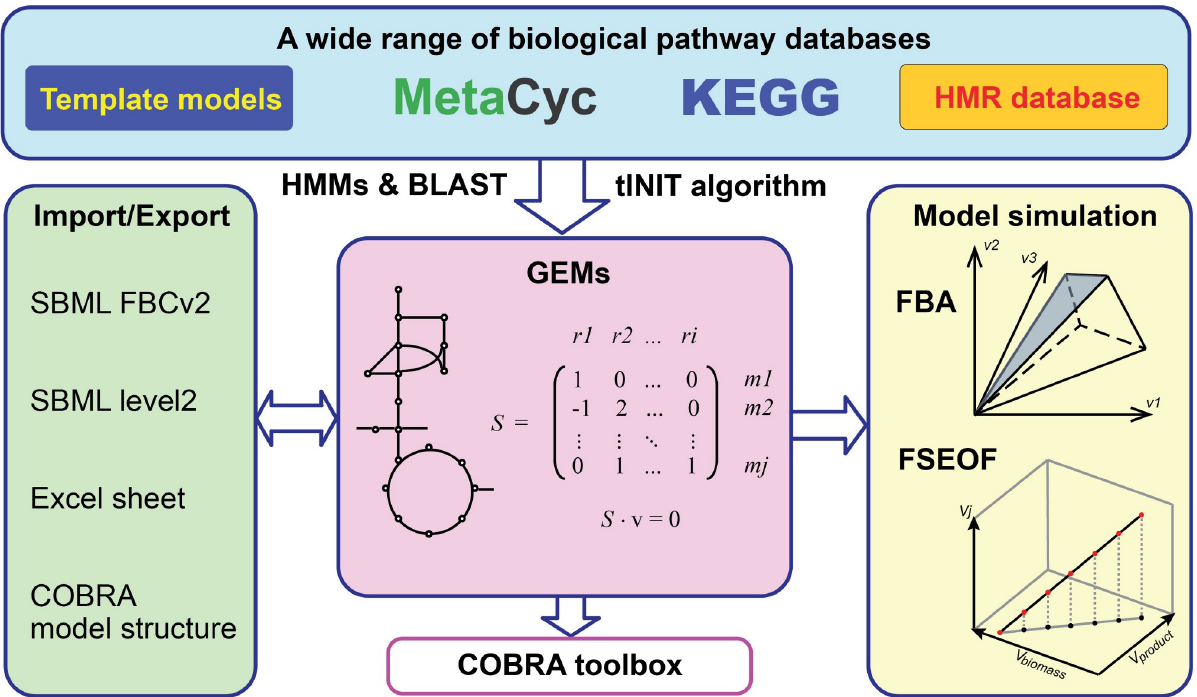
Fig 1. Schematic overview of RAVEN toolbox version 2.0. RAVEN was significantly enhanced for de novo draft model reconstruction by integrating knowledge from different sources (e.g. KEGG and MetaCyc). It has better import/export support to relevant formats, and especially improved compatibility with the COBRA Toolbox by resolving previously conflicting function names and providing a bi-directional model conversion function. As a MATLAB toolbox, RAVEN provides one unified environment for both model reconstruction and simulation analysis (e.g. FSEOF) and allows scripting for more flexible